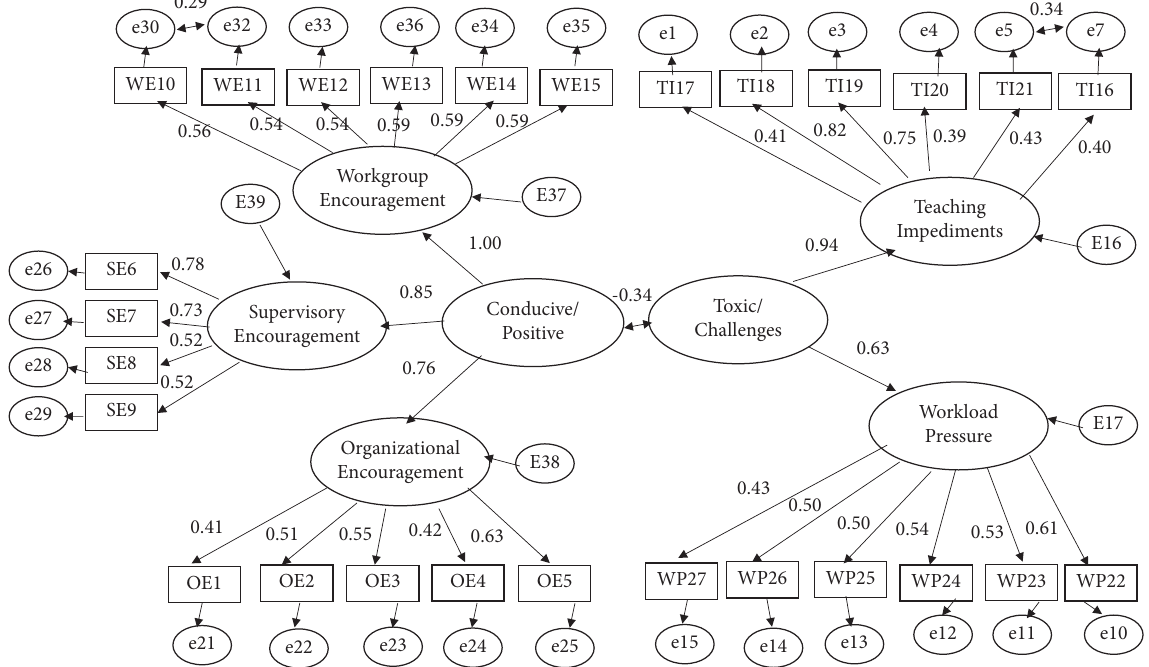
Figure 1: Work environment recursive model (Amos output). Note. CMIN/DF � 2.434; CFI � .811; GFI � .867; AGFI � .842; RMSE � .062; SRMR �